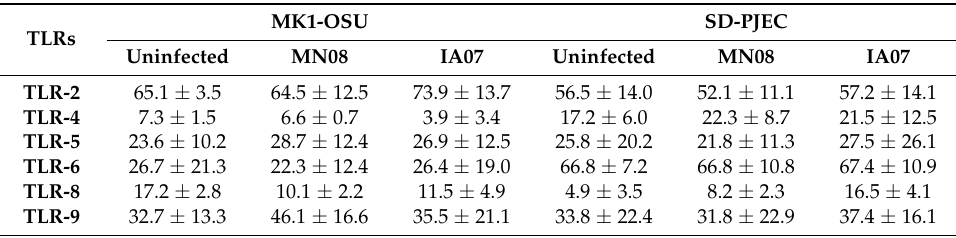
Table 4. Percentage of cells expressing TLRs-2, -4, -5, -6, -8, and -9 in MK1-OSU and SD-PJEC cells 24 h after influenza virus infection as determined using a flow cytometer. Values represent the average for four to six experiments ± SE. There was no significant difference in the expression between the infected and uninfected